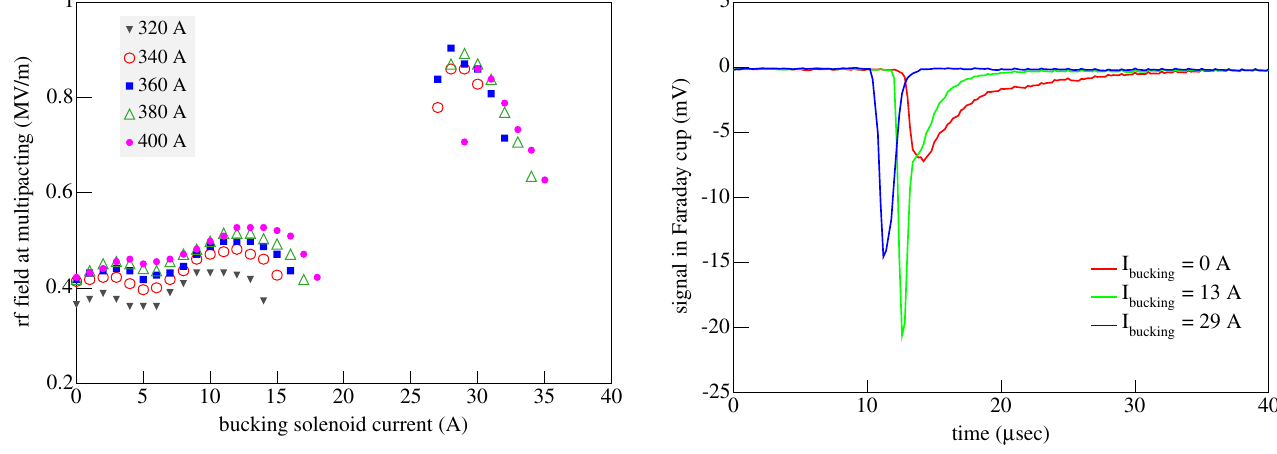
FIG. 12. (Color) Fitted rf field at multipacting ( E ) corre- FIG. 14. (Color) Shape of the multipacting peak for several MP ) measurements shown in Fig. sponding to the delay time ( t bucking solenoid currents at a main solenoid current of 400 A. rear